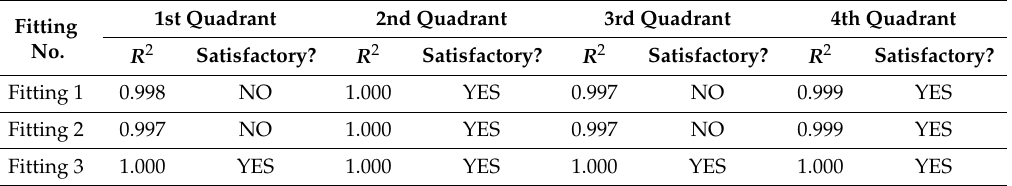
Table 10. Goodness of fit for the case of the damaged hull due to